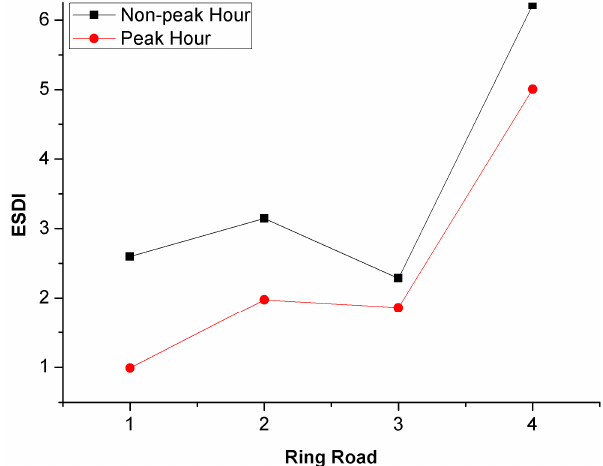
Figure 7. Average ESDI of the ring area.